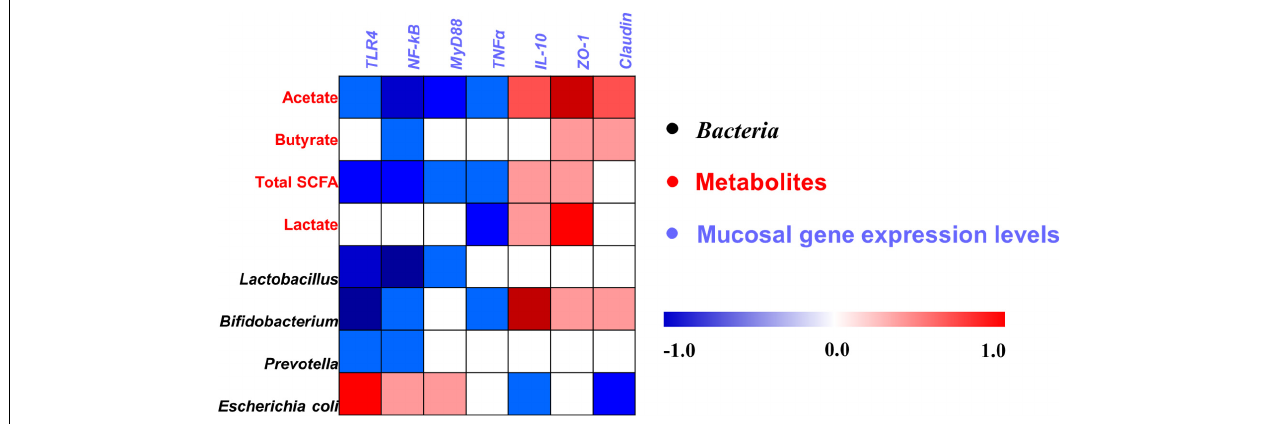
FIGURE 8 | Pearson’s correlation analysis between the abundance of ileal microbiota (qPCR), microbial metabolites, and mucosa gene expression level affected by dietary treatment. Cells are colored based on the correlation coefficient between the significantly changed bacteria (the numbers of bacteria), metabolites (concentrations), and mucosal gene expression level. The intensity of the colors represents the degree of association. Red represents a significant positive correlation ( P < 0.05), blue represents significantly negative correlation ( P < 0.05), and white shows that the correlation was not significant ( P > 0.05). Total SCFA, total short-chain fatty